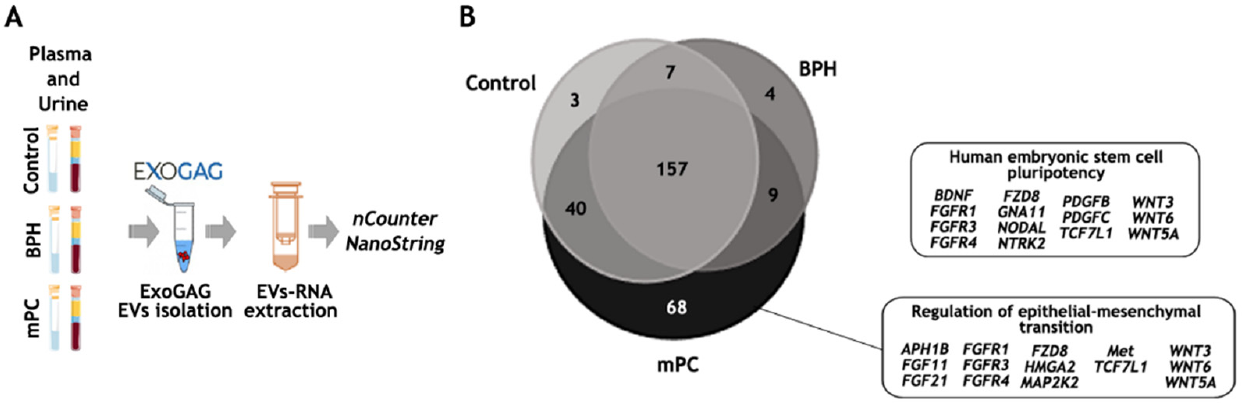
Figure 5. EV-mRNA analysis on the nCounter NanoString platform. ( A ) Workflow for EV-mRNA purification and analysis on the nCounter platform: EVs were isolated with ExoGAG technology from plasma and urine samples. EV-mRNA was purified using DBT Kit with a previous lysis step of TRIzol-chloroform. Next, a retro-transcription and a pre-amplification step were performed prior to hybridization with the Pancancer Pathways panel. ( B ) Total genes identified in control, BPH and mPC plasma EV samples represented in a Venn diagram showing 157 common genes and 3, 4 and 68 genes represented only in the control, BHP and mPC, respectively, once the threshold value was established. The main IPA signaling pathways represented by 68 genes expressed only in mPC plasma sample were related to the human embryonic stem cell pluripotency pathway and regula- tion of epithelia-mesenchymal transition pathway. This figure was produced using Servier Medical Art (https: //smart.servier.com) licensed under a Creative Commons Attribution 3.0 Generic License.